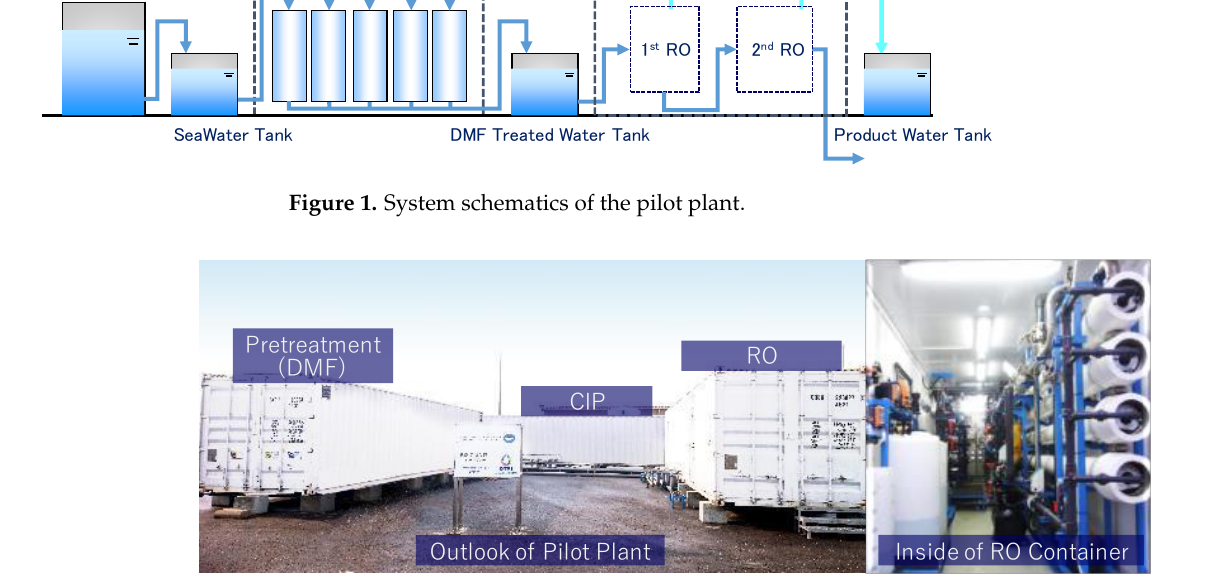
Figure 2. Appearance of the pilot plant.